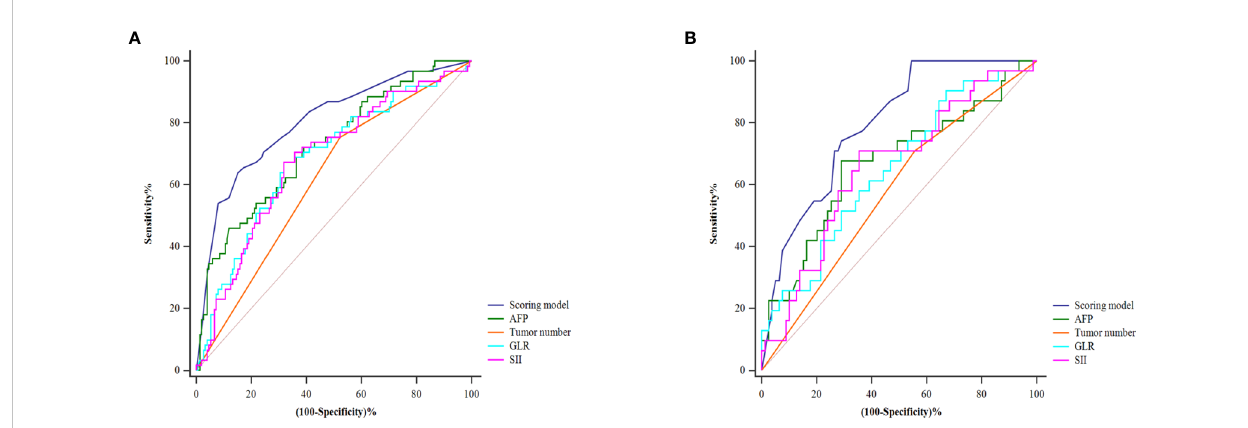
FIGURE 4 The predictive performance of the model and the comparison with the AFP, tumor number, GLR and SII in the development (A) and validation (B)